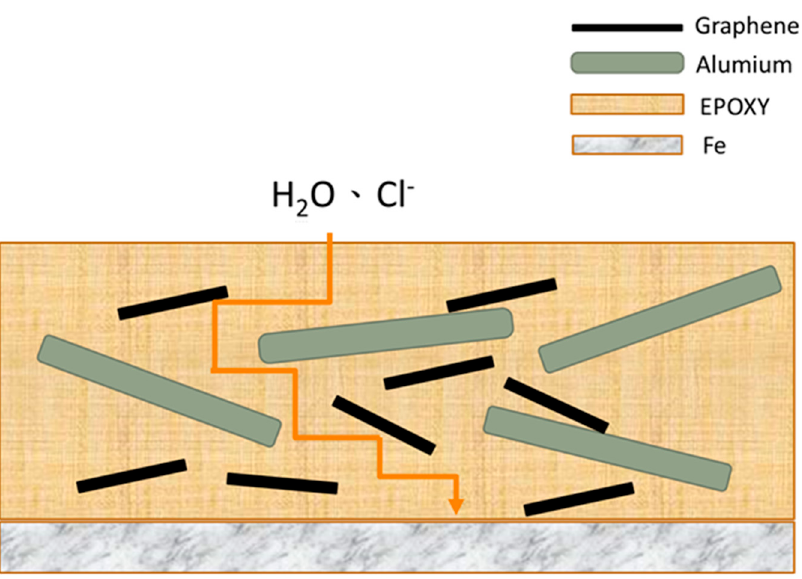
Figure 16. Schematic for the mechanism of improved anticorrosion in epoxy coatings with Al-GN fillers.